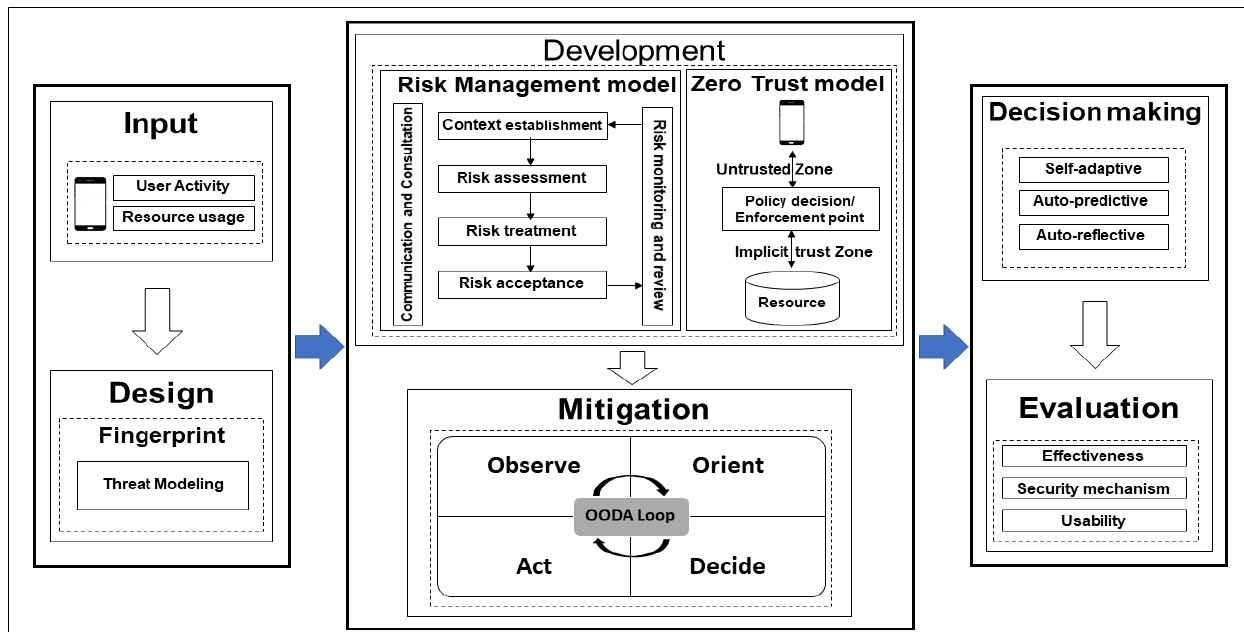
Figure 12. Conceptual framework of mobile device behavior fingerprint for APT mitigation.